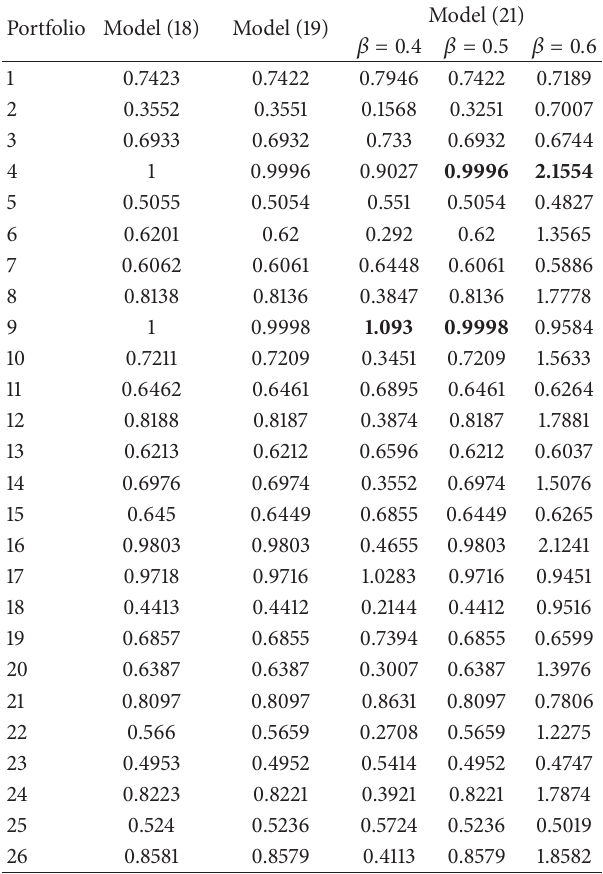
Table 2: Obtained efficiency for models (18), (19), and